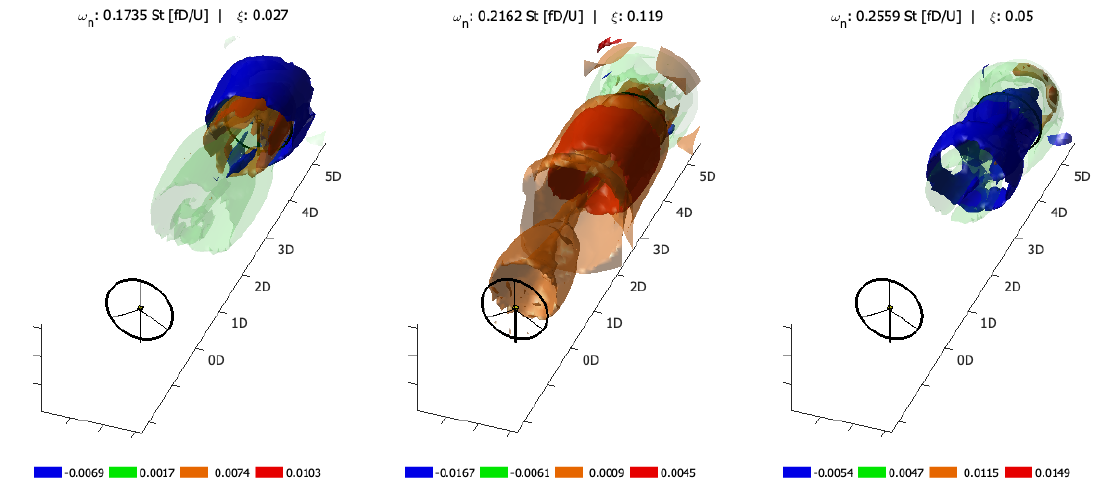
Figure 7. DMD modes #1, #2 and #4. Mode #1 corresponds to a background mode that is not changing (i.e., it has zero eigenvalue). The negative value isosurfaces of mode #1 indicate the different regions marked by velocity deficits inbetween the upstream and downstream turbines.